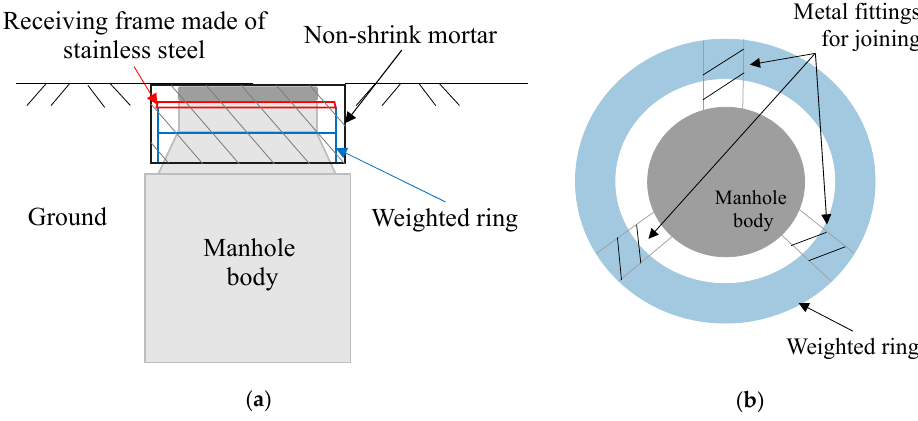
Figure 2. Outline of structure of weighting method. ( a ) Cross-sectional view ( b ) Plan view